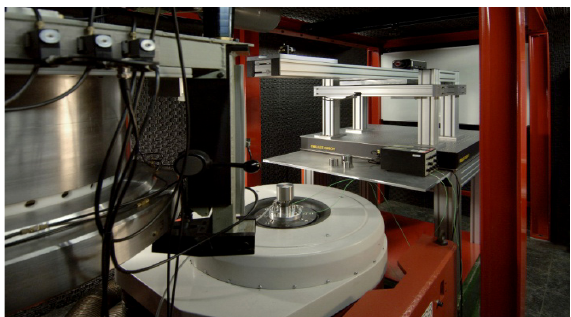
Fig. 4. Photo of the PTB installation.